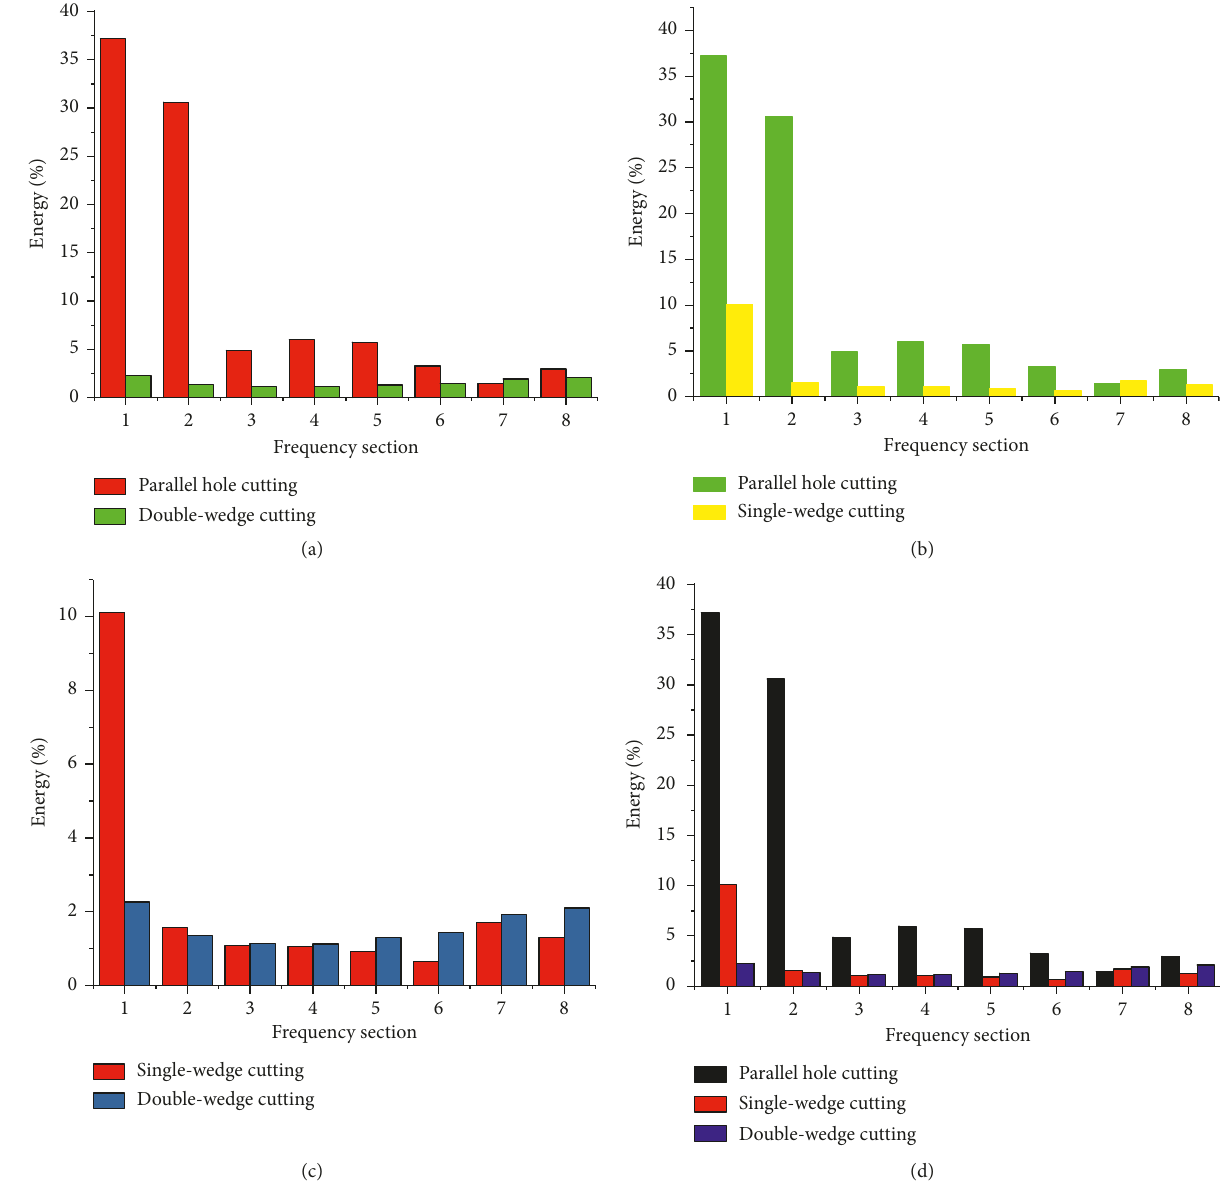
Figure 13: Energy percent distribution diagram of the cutting method during 250Hz (1: 0–31.25Hz, 2: 31.25–62.5 Hz, 3: 62.5–93.75Hz, 4: 93.75–125Hz, 5: 125–156.25Hz, 6: 156.25–187.5Hz, 7: 187.5–218.75Hz, 8: